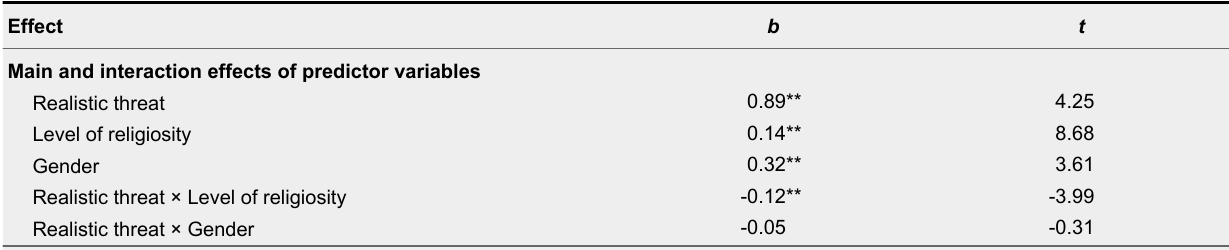
b Coefficients for the Model 3: Realistic Threat, Religiosity and Gender on the Second Factor of Prejudice